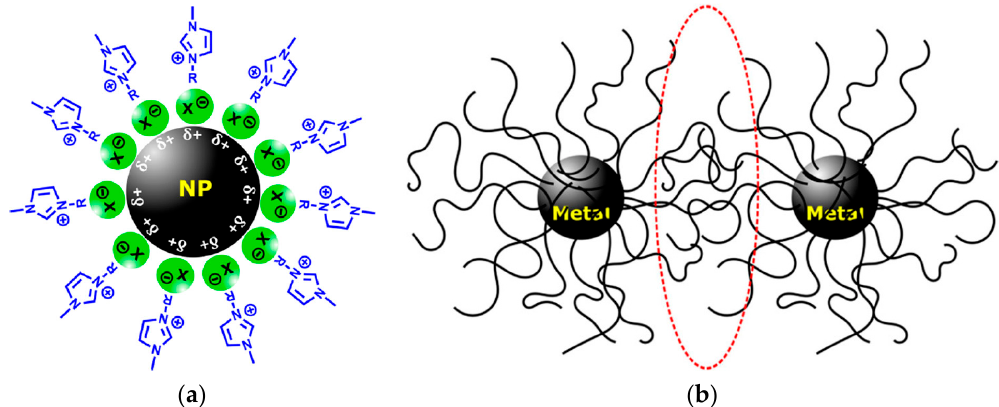
Figure 9. Schematic representation of the electrostatic ( a ) and steric ( b ) stabilization mechanisms of nanoparticles. In the former mechanism, the nanoparticles (NPs) are stabilized due to electrostatic repulsion of the positively charged outer layer. Steric repulsion between the surfactant hydrophobic chains contributes to NP stabilization [219]. Reprinted with permission from ref. [219]. Copright 2021 Springer Nature.